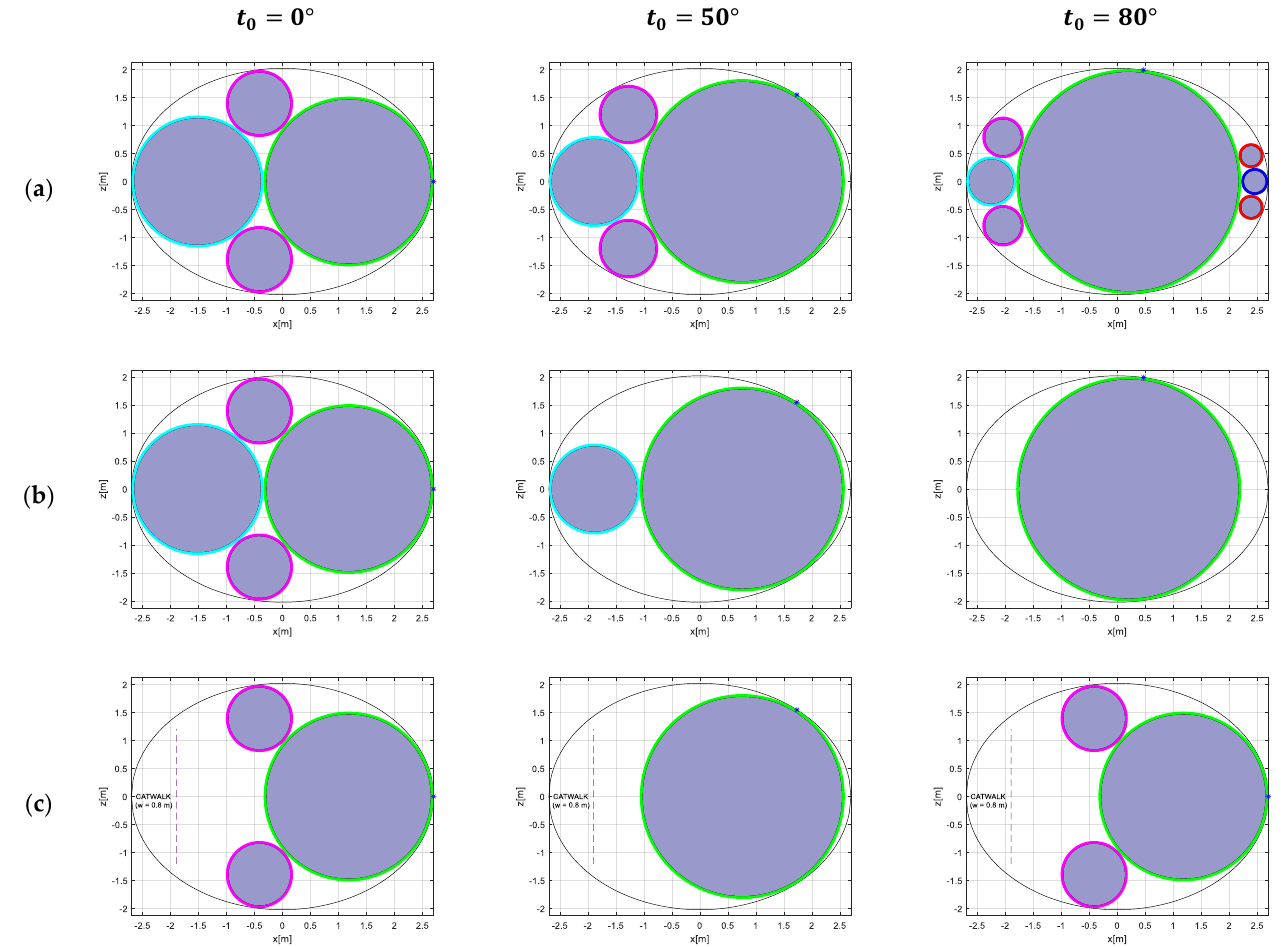
Figure A2. Fuselage and tank cross-sections: ( a ) without 𝑅 𝑚𝑖𝑛 constraint; ( b ) with 𝑅 𝑚𝑖𝑛 = 0.5 m; ( c ) with 𝑅 𝑚𝑖𝑛 = 0.5 m and catwalk width = 0.8 m.